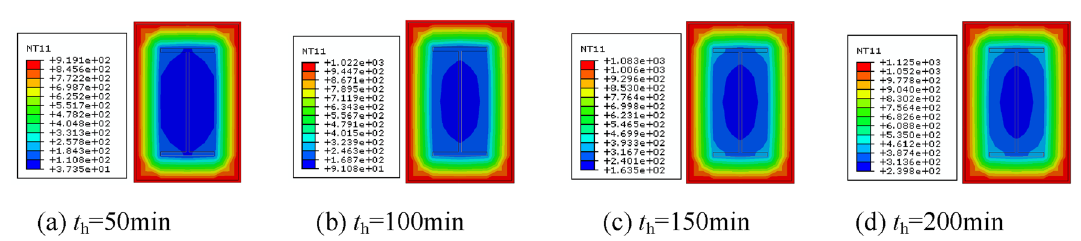
Figure 7. Cross-sectional temperature clouds at various stages of the fire on all four surfaces.